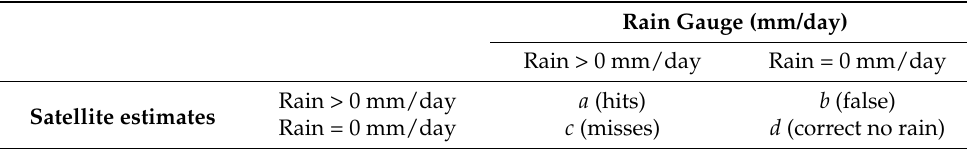
Table 3. Cross-table of categorical rainfall